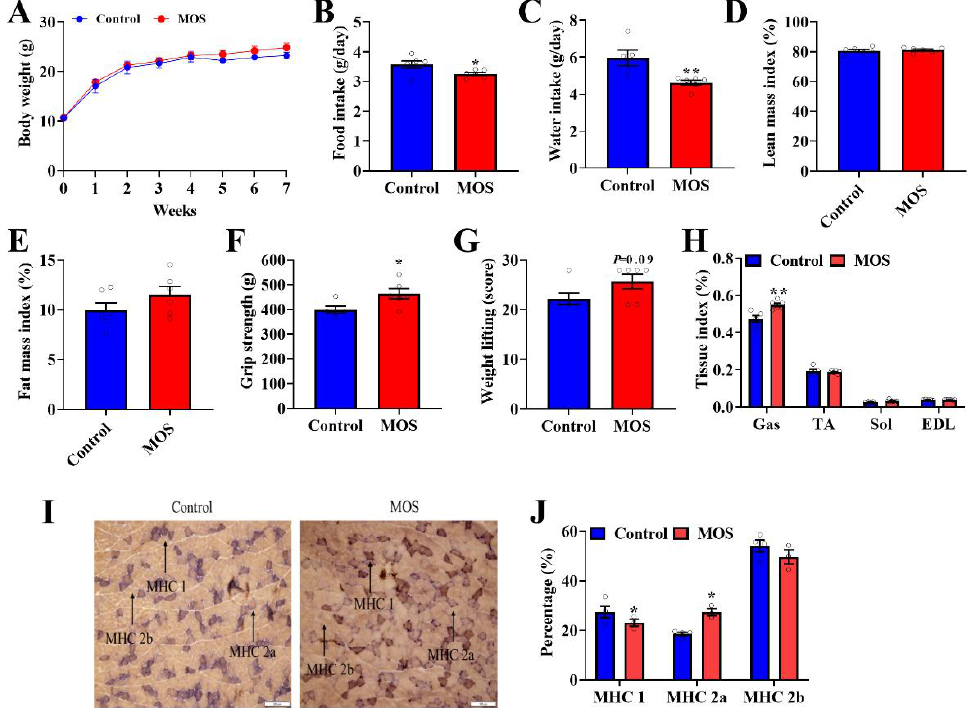
Figure 1. Mannan oligosaccharide supplementation shows positive effects on the gastrocnemius. ( A ) Body weight of mice. ( B ) Average daily food intake. ( C ) Average daily water intake. ( D , E ) QMR analyses of body composition of mice. ( F ) The grip strength of mice. ( G ) The weight test of mice. ( H ) The GAS, TA, SOL and EDL tissue indices of mice. ( I , J ) Staining of ATPase in GAS. * p < 0.05 versus the control group, ** p < 0.01 versus the control group.